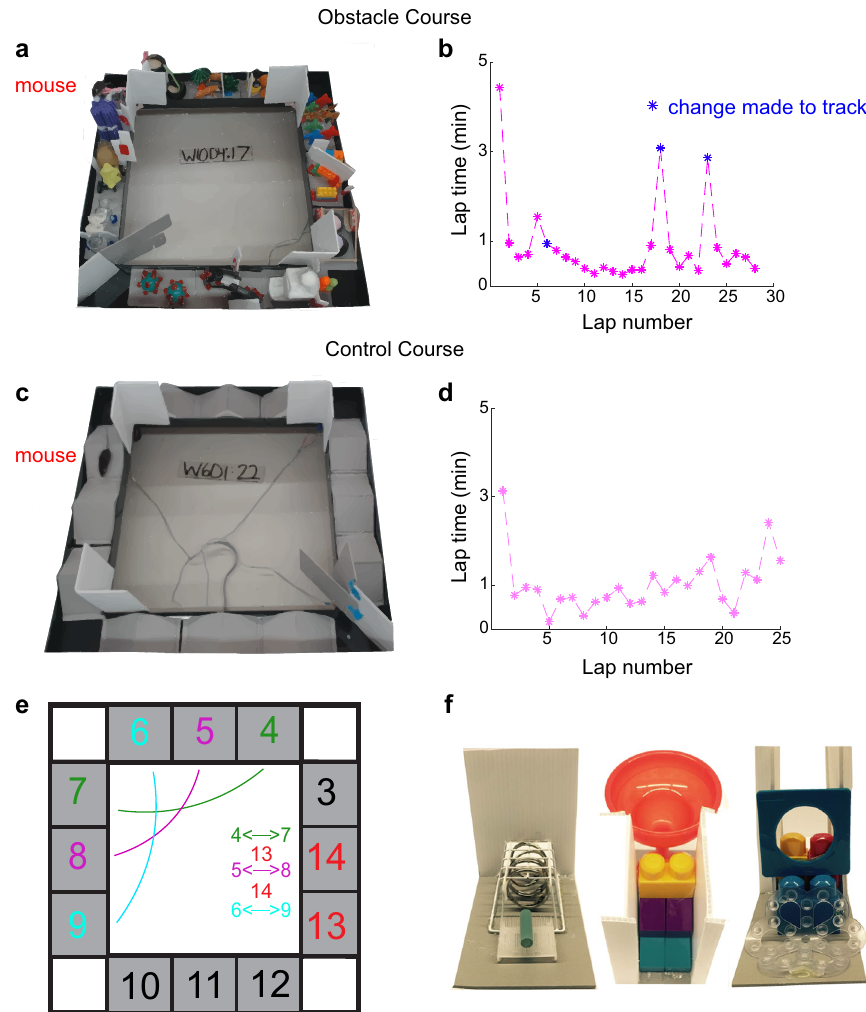
Fig. 1 The obstacle course paradigm. a Example OC track fi lled with 12 inserts. b Example lap time data for a 30-min duration on the OC. Note that animals tended to take longer to complete a given lap when a change to the track was performed immediately prior to the lap (blue asterisk). See Supplementary Video 2 for a demonstration of the animal change in speed pre and post-change to the track. c An example CC track fi lled with 12 hurdles. d Example lap time data for a 30-min duration on the CC. No changes were made to the CC throughout a given session. e Schematic of changes made in a 1-h OC session. A total of 5 changes were made, which included three rearrangements (e.g., swapping obstacle 4 with obstacle 7, indicated by arrows) interleaved with two replacements of old inserts with new ones (indicated in red). See Supplementary Fig. 1 for a detailed OC and CC protocol. f Three example obstacles used in the OC (12 for the entire